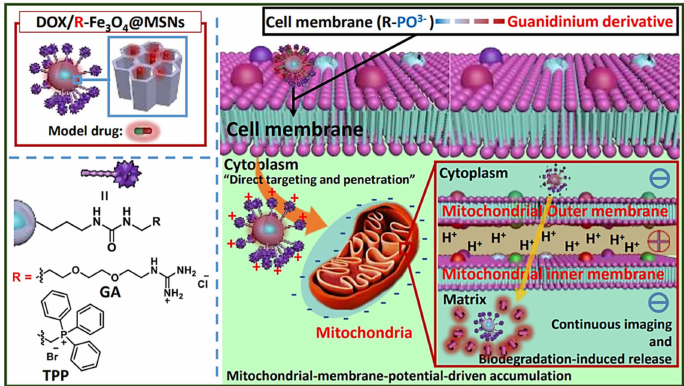
Figure 4. Schematic representation of MSNs functionalized with guanidinium derivatives for mitochondrial targeting. The GA-functionalized MSNs accumulated faster into the mitochondria, compared with the TPP derivatives. Reproduced from Ref. [83] with permission from The Royal Society of